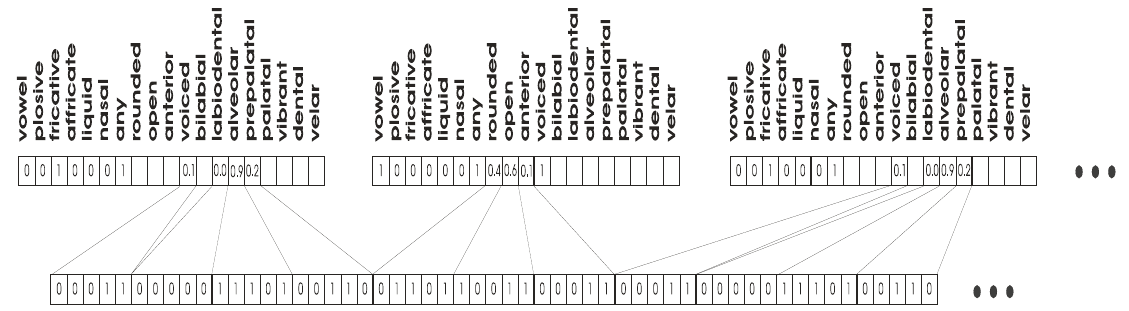
Figure 12. Example of the chromosome obtained by coding.